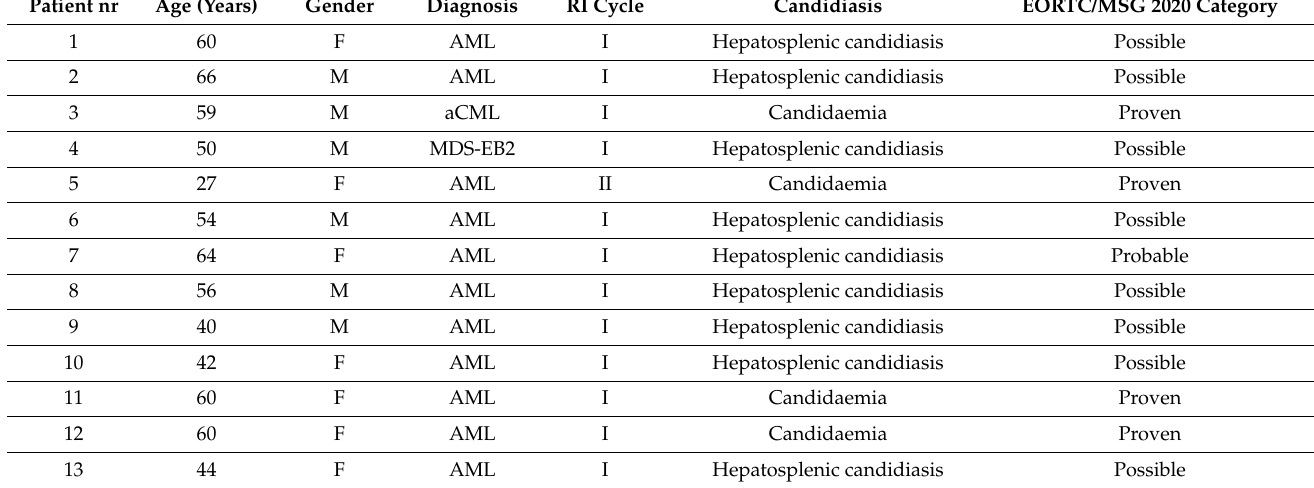
Table 3. Characteristics of patients experiencing